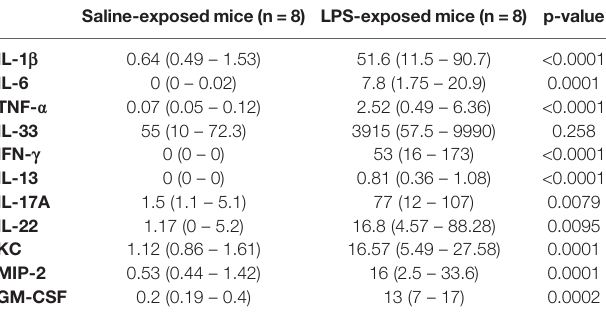
TABLE 1 | Lung tissue cytokines in wild-type BALB/c mice exposed to saline or LPS. Saline-exposed mice (n = 8) LPS-exposed mice (n = 8) p-value IL-1